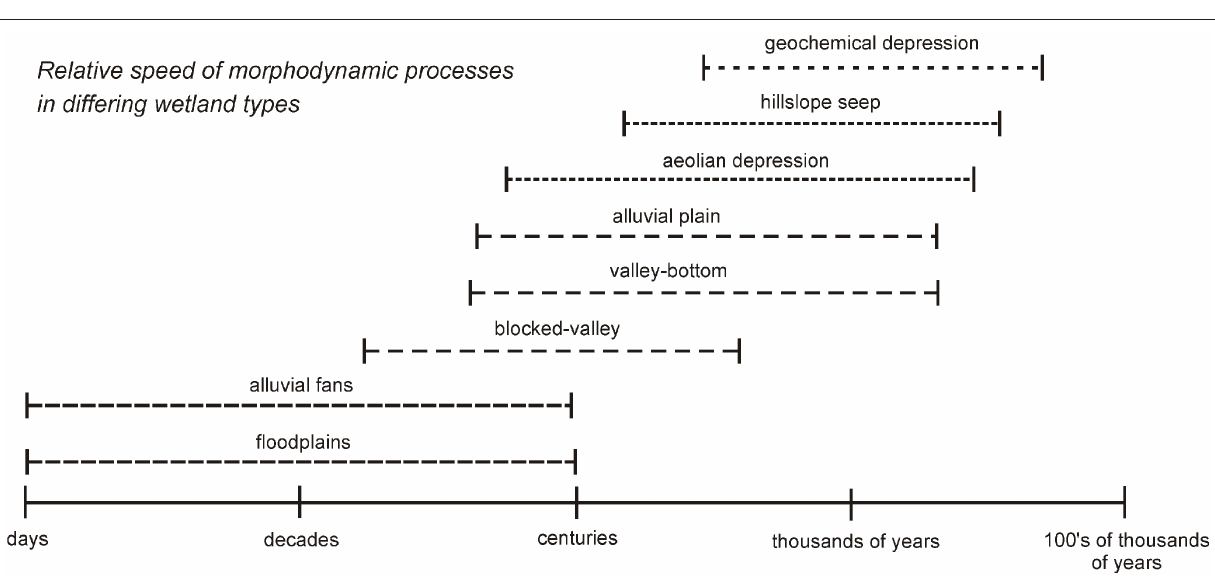
FIGURE 9 | Wetland types and their associated processes and dynamics may be nested. For example, the Okavango Delta is an alluvial fan in a tectonic setting (A) . On the panhandle, different types of floodplain wetlands occur due to downstream variation in sediment supply and discharge regime (B,C) . In the fan region, tree-fringed geochemical depressions occur (D) . All images from Google Earth.